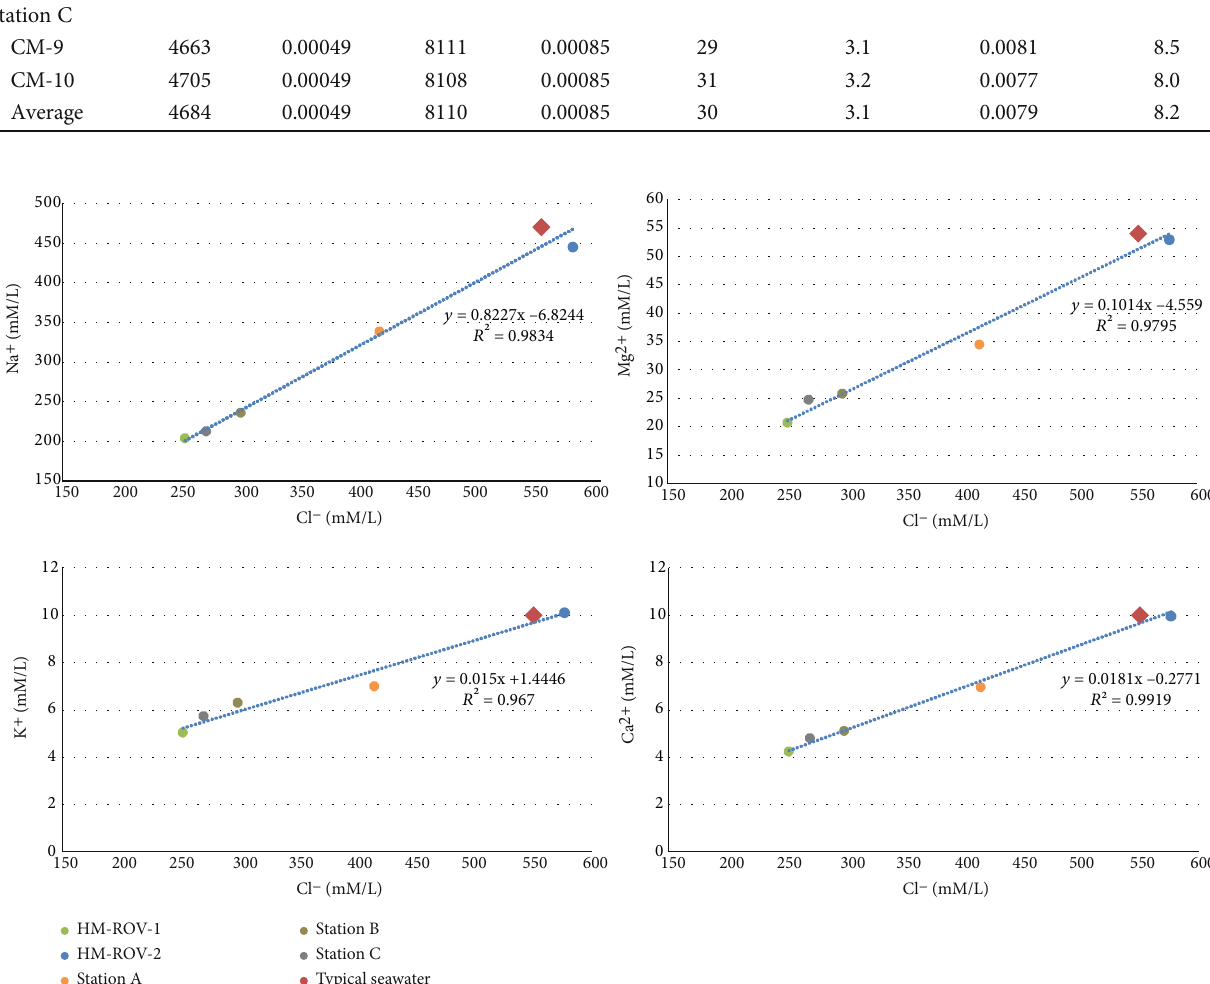
Figure 4: Comparison of the concentrations of Na + , Mg 2+ , K + , and Ca 2+ with the Cl - concentration, separately. The values from our samples and those of typical seawater lie roughly along a straight line, proving the strong in fl uence of seawater and similar